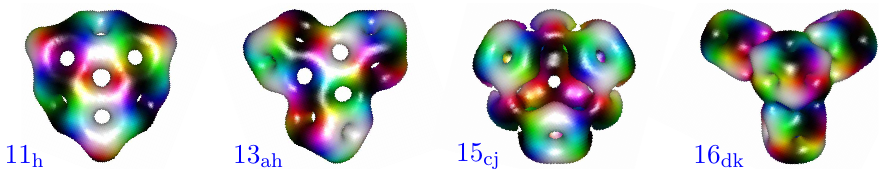
Figure 9. Skyrmions with at least C 3 symmetry.